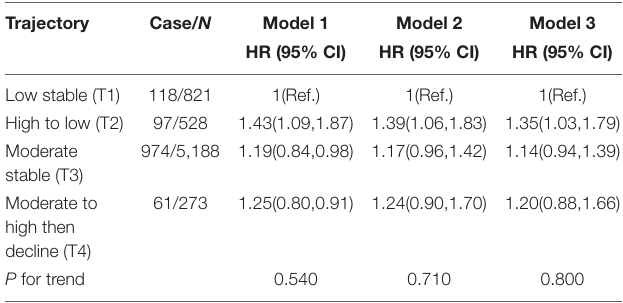
The relationships between dietary BCAA intake trajectories